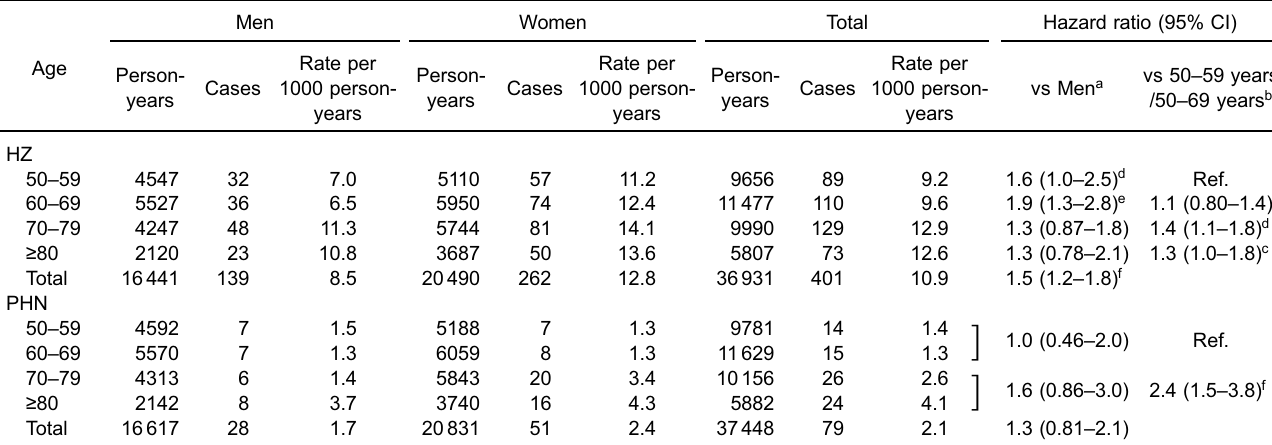
Risk of Herpes Zoster and Postherpetic